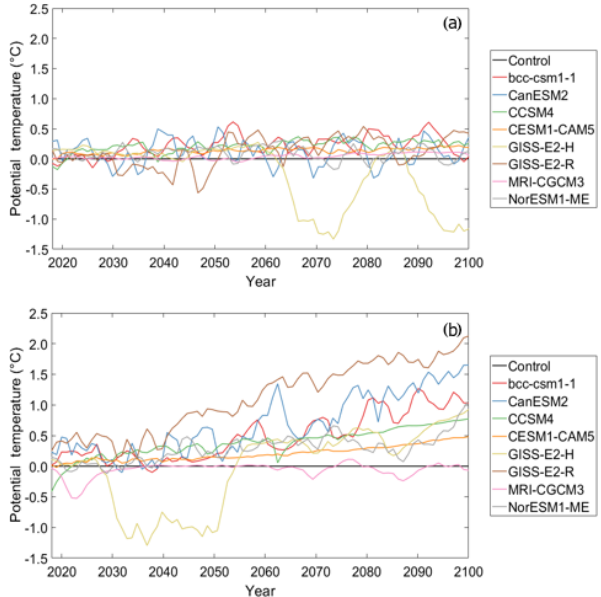
Figure 2. Projected 21st century ASE ocean potential tempera- ture anomalies averaged over 400–700m depth range. Anomalies are relative to the depth averaged 400–700m mean from 2005 to 2016. Each line represents a member of the CMIP5 AOGCM sub- set forced with the RCP8.5 (a) and RCP2.6 (b)